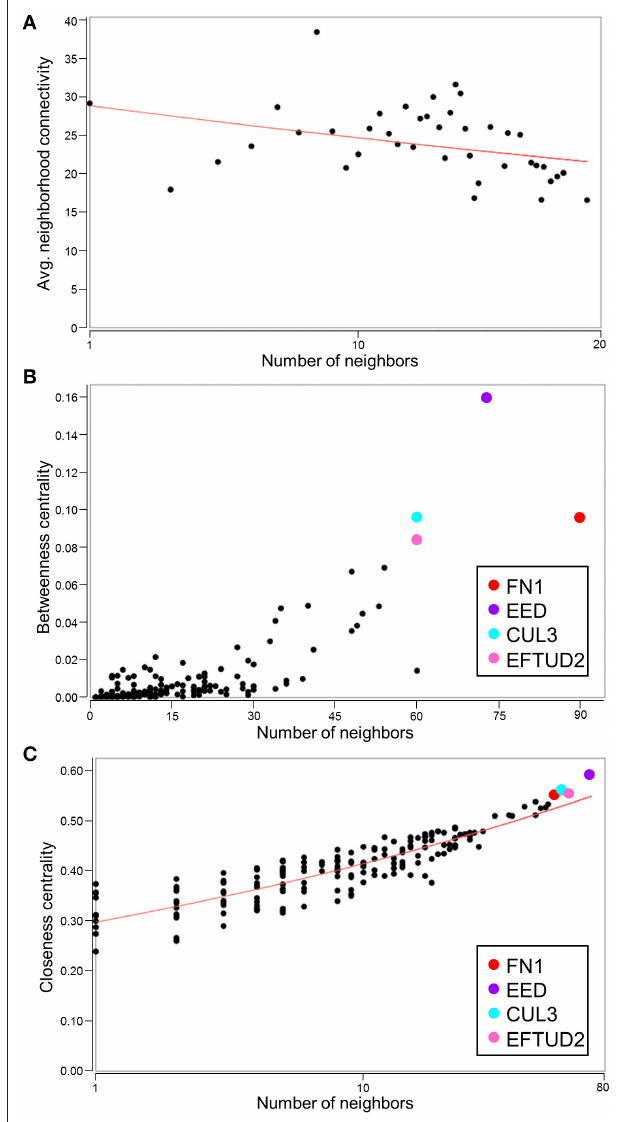
FIGURE 7 | Identification of hubs within the merged network of NUP155 protein-protein interactions. (A) Negative slope (red line) indicates that disassortative mixing is preserved in the larger, merged network comprising the top 5 subnetworks (175 nodes), all of which depict RNA trafficking and RNA post-transcriptional modification as highly prioritized functions. (B,C) Hubs within the merged network include FN1 (red), EED (purple), CUL3 (cyan), and EFTUD2 (pink) in both topological analysis plots of betweenness centrality and closeness